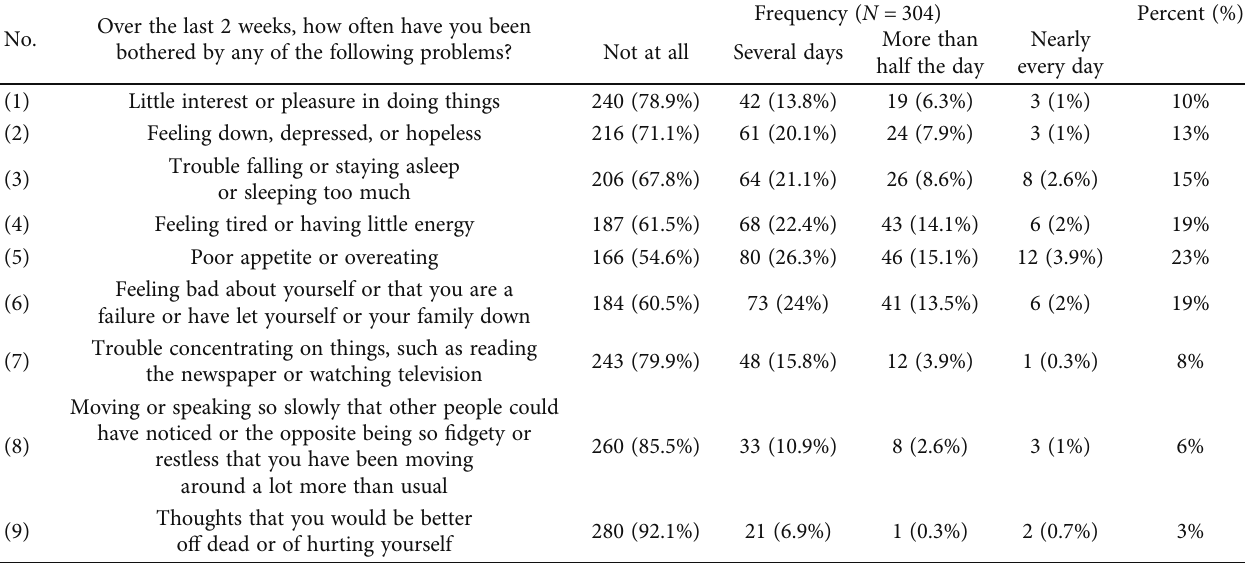
Table 4: Depression symptoms on HF patients in West Gojjam Zone public hospitals, Northwest, Ethiopia, 2021 ( N = 304 ).